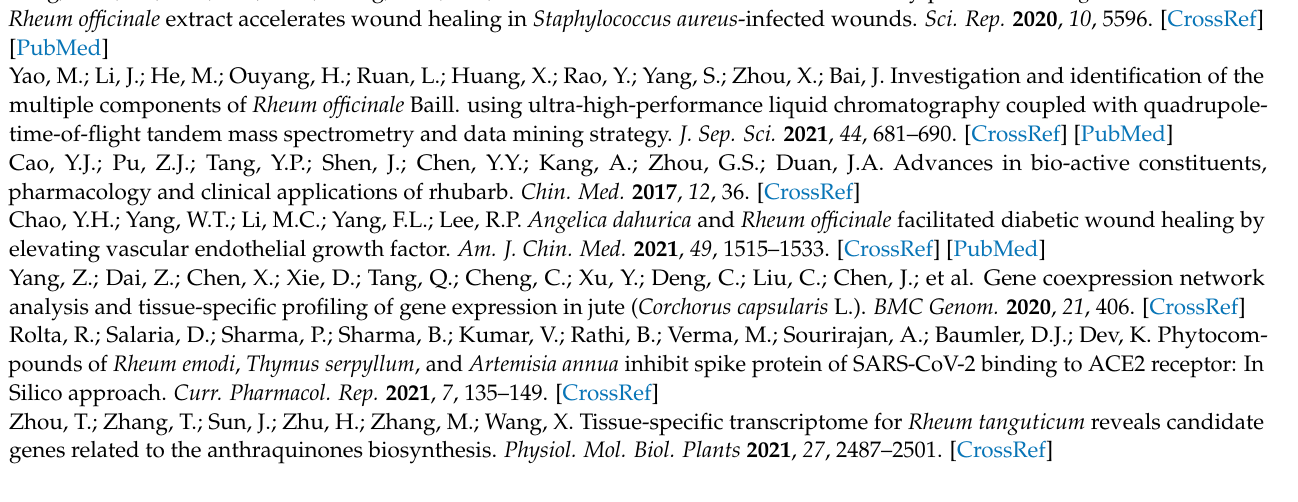
Ro_L. Table S7: The repeat number of SSR repeat types. Table S8: Statistics of the number of SSR motifs. Table S9: Candidate type III polyketide synthases downloaded from NCBI. Table S10: The primers used in this study for qRT-PCR of randomly selected unigenes. Table S11: SSR primer pairs designed based on the candidate SSR loci in the transcriptome of R. officinale